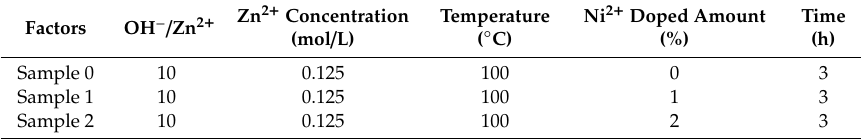
Table 1. Processing parameters of Zn 1-x Ni x O nanorod arrays with di ff erent concentrations.